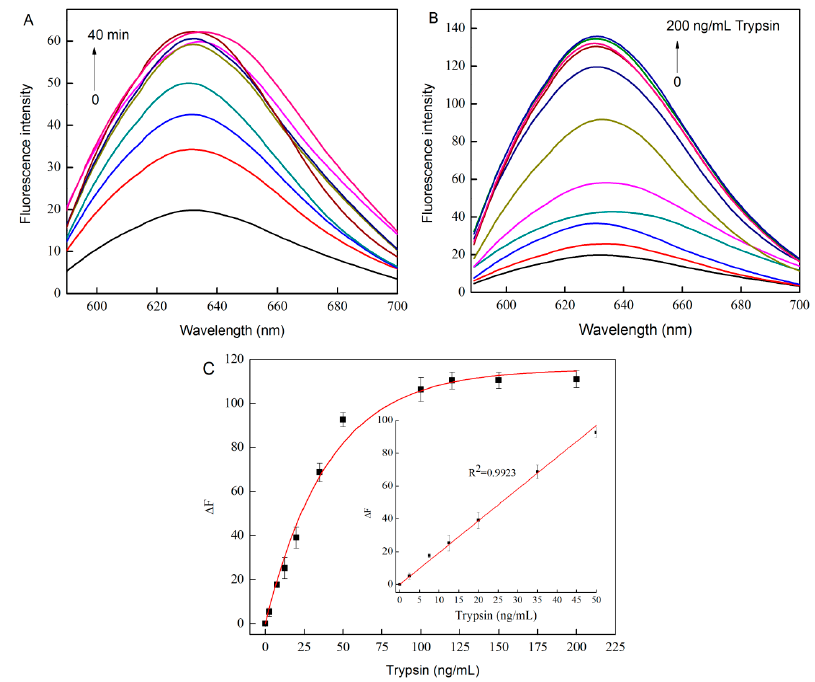
Figure 3. Fluorescence spectra of peptide (200 nM) in the presence of trypsin (20 ng/mL) incubated at 37 °C for different periods ( A ). Fluorescence spectra of the assay system at various concentrations of trypsin ( B ). Relationship of the fluorescence intensity changes of the assay system with trypsin concentration. Inset shows the linear response of this system to trypsin ( C ).